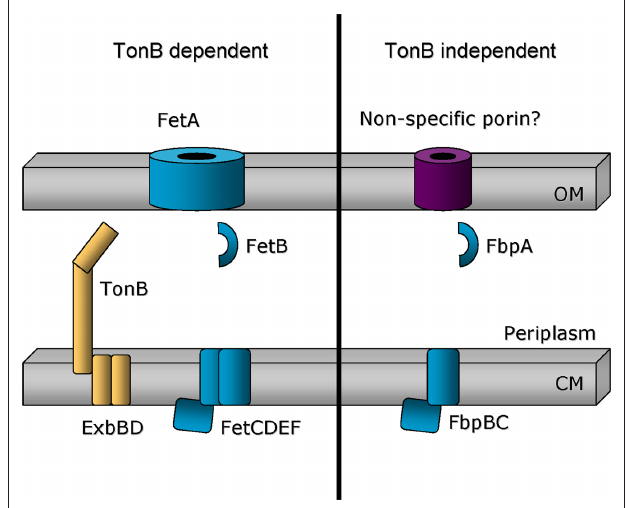
Figure 5 | Model comparing TonB-dependent and TonB-independent iron acquisition systems. Left: Ferric-catecholate siderophores are imported through the outer membrane in a TonB- and FetA-dependent mechanism. Use of these ferric-siderophores is expected to require proteins encoded by genes located downstream of fetA . Right: In gonococcal strain FA19, use of ferric-catecholate siderophores is limited to a TonB-independent mechanism that involves the participation of the FbpABC system. Gonococcal strain FA1090 appears to be able to employ both TonB-dependent and TonB- independent mechanisms for the use of ferric siderophores, including enterobactin, DHBS,